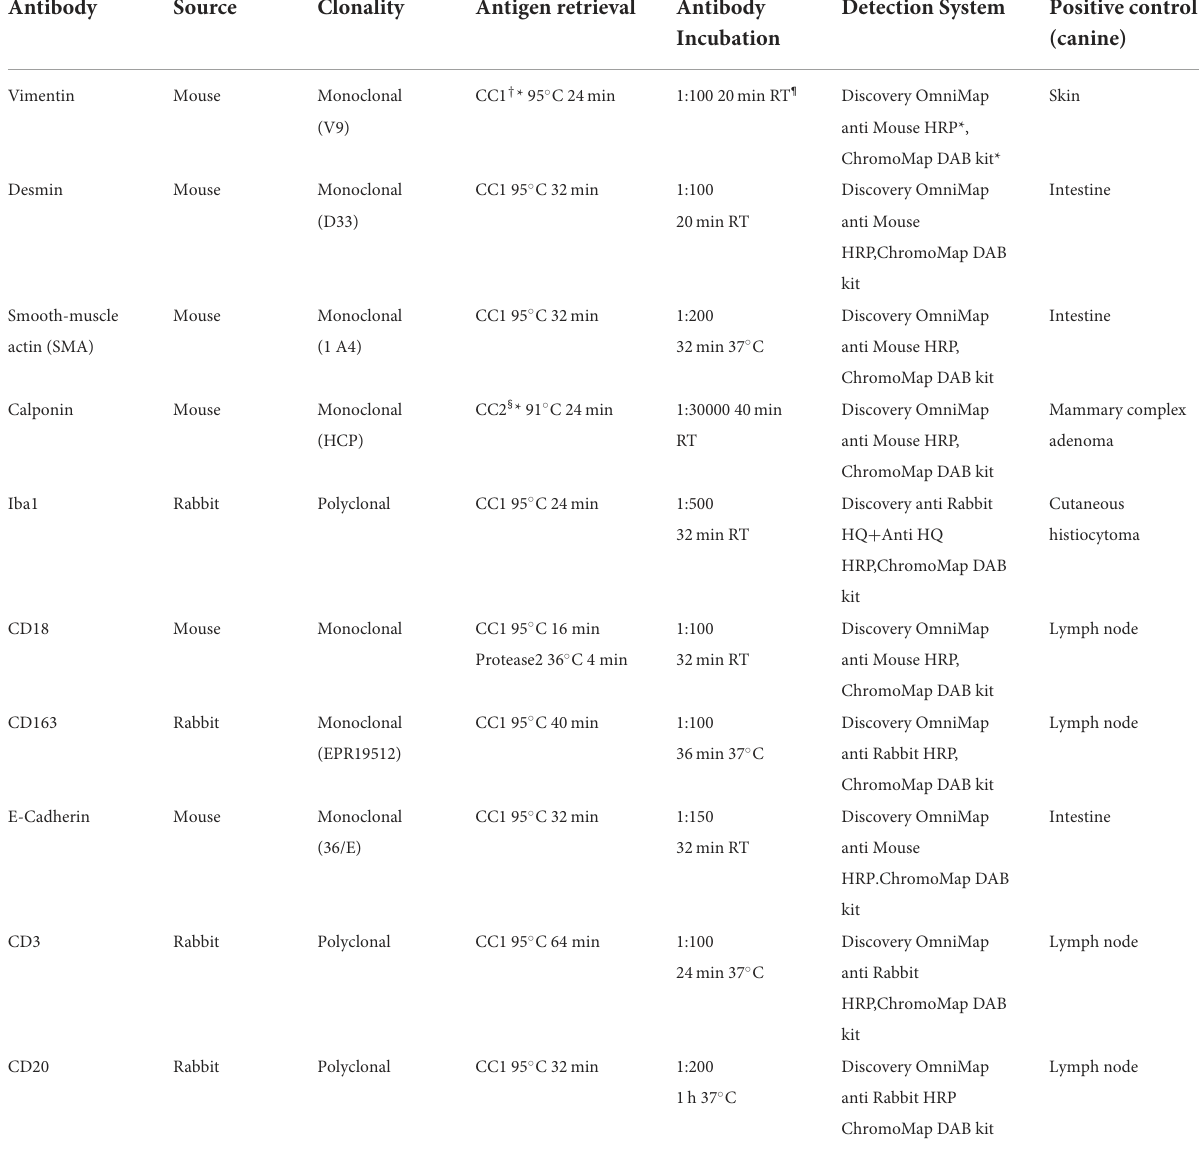
TABLE 1 Panel of antibodies applied to 37 splenic nodular lesions with stromal, histiocytic, and lymphoid components. Antibody Source Clonality Antigen retrieval Antibody